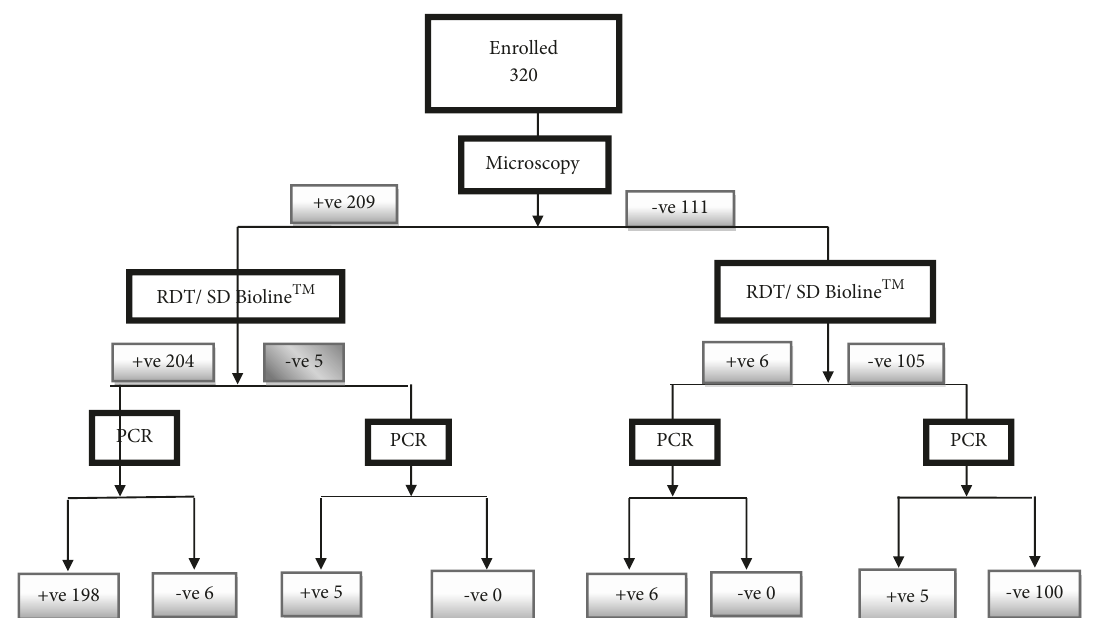
Figure1:Flowchartforthediagnosisofmalariausingregularlightmicroscopy,SDBioline (cid:2)